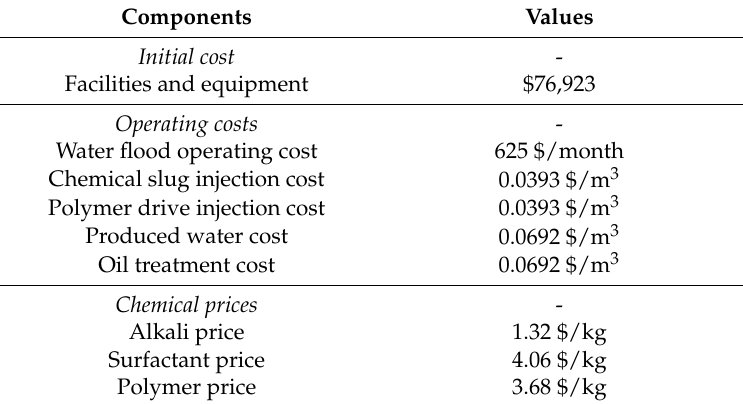
Table 5. Assumed chemical prices, operating costs, and initial investment for calculating the